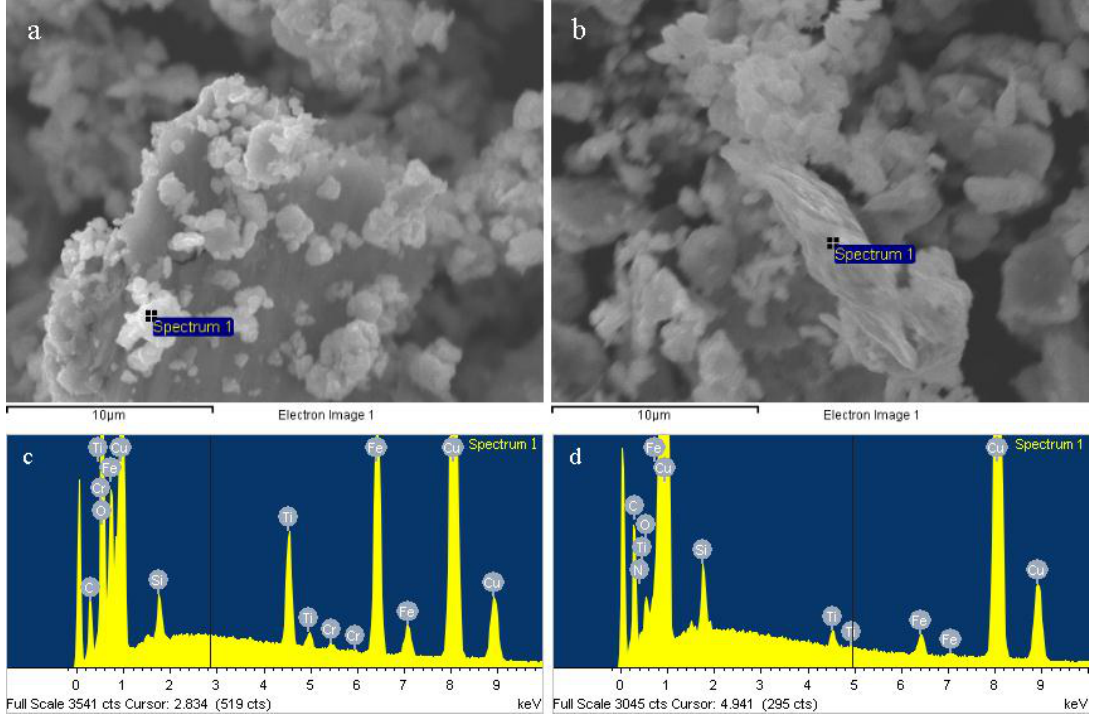
Figure 10. ( a ) and ( b ) SEM of debris surfaces; ( c ) and ( d ) the EDS spectra of the marked spot in ( a ) and ( b ), respectively.